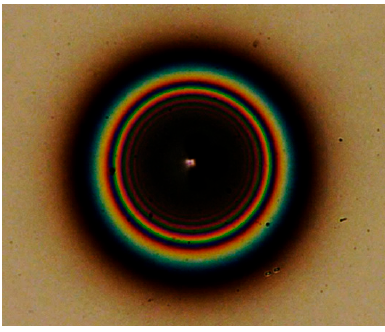
Figure 9. An optical microscope image for the film on Si wafer shown in Figure 8.